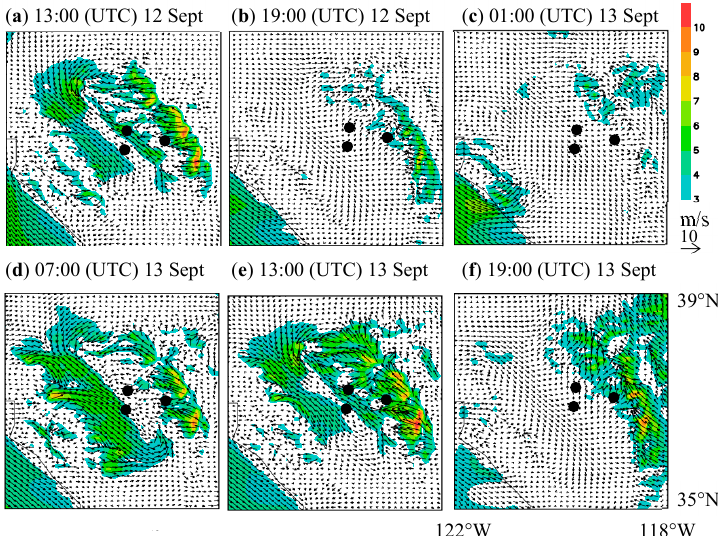
Figure 9. Near-ground wind behavior in Area-S, simulated using a regional SCALE model (resolution of 5 km × 5 km). Images are given for each 6-hour period between 13:00 (UTC) on 12 September and 19:00 (UTC) on 13 September 2020 ( a – f ). The black dots denote the three AERONET observation sites. During the observation period, the winds at Fresno_2 always blew from the north- west, flowing inland from the Pacific Ocean, and wind speeds were lower during the day.